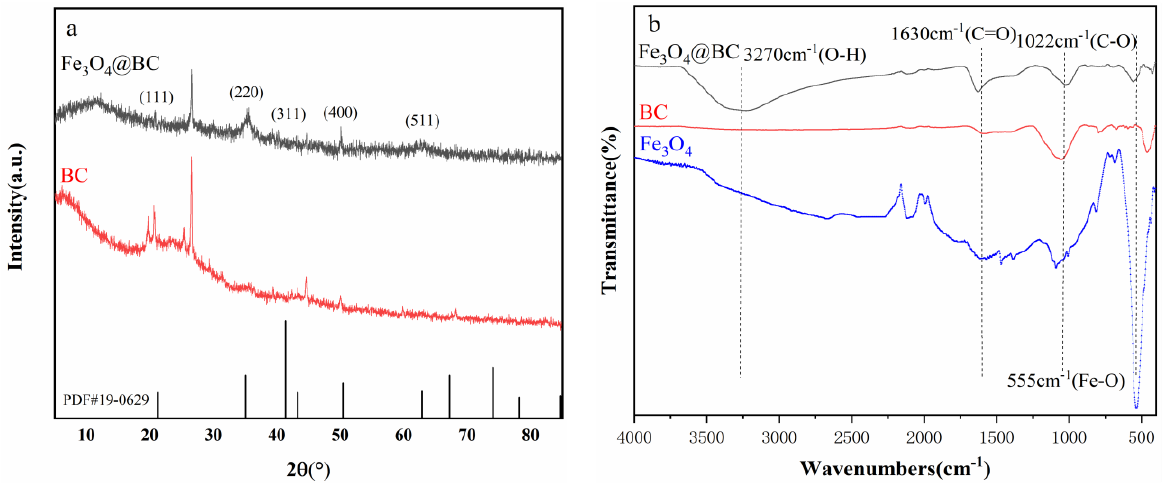
Figure 2. ( a ) XRD patterns of BC and Fe 3 O 4 @BC; ( b ) FT-IR spectra of BC and Fe 3 O 4 @BC.